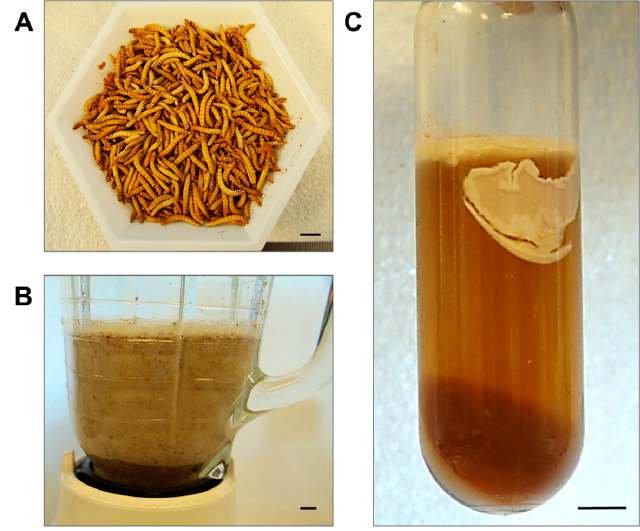
Figure 1. Preparation of T. molitor larval extract. ( A ) Cold-acclimated larvae (100 g). ( B ) Larval homogenate after blending for 30 s in 300 mL of lysis buffer. ( C ) Homogenate after centrifugation for homogenate after blending for 30 s in 300 mL of lysis bu ff er. ( C ) Homogenate after centrifugation for 30 min. Scale bars in the right corner of each photograph represent 1 cm. 30 min. Scale bars in the right corner of each photograph represent 1